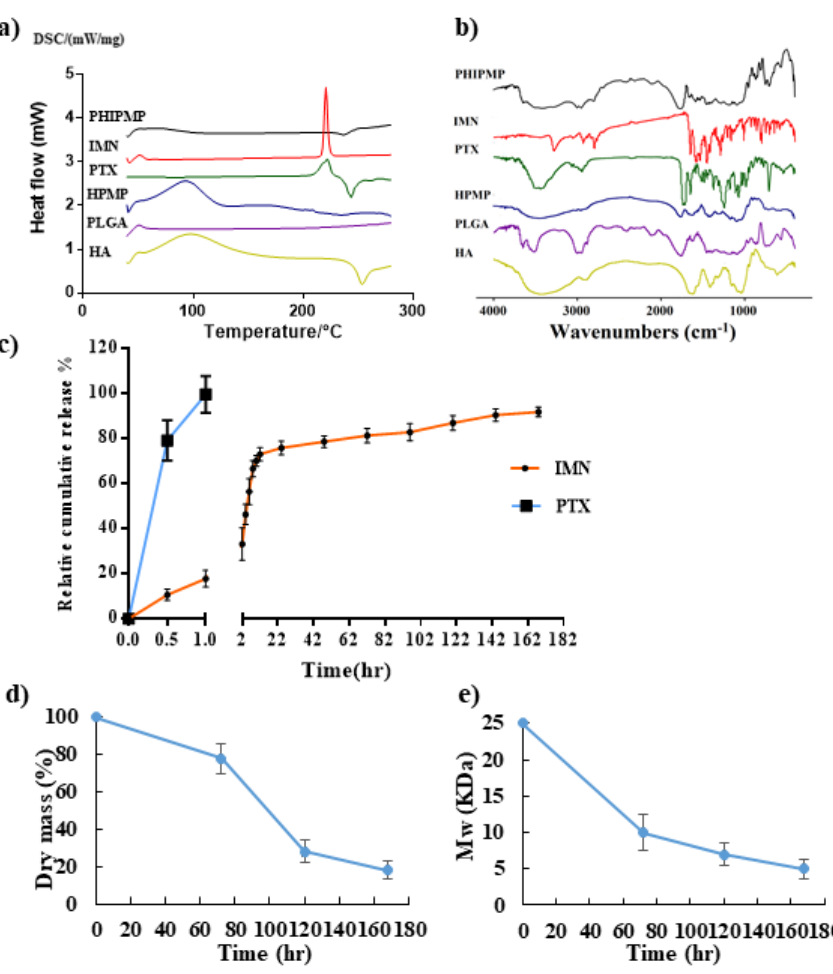
Figure 3. Characteristics of PHIPMPs: ( a ) DSC; ( b ) FTIR; ( c ) in vitro release of IMN and PTX in PHIPMPs; ( d ) weight change in PHIPMPs; ( e ) average molecular weight change of PHIPMPs ( n = 3, mean ± SD).